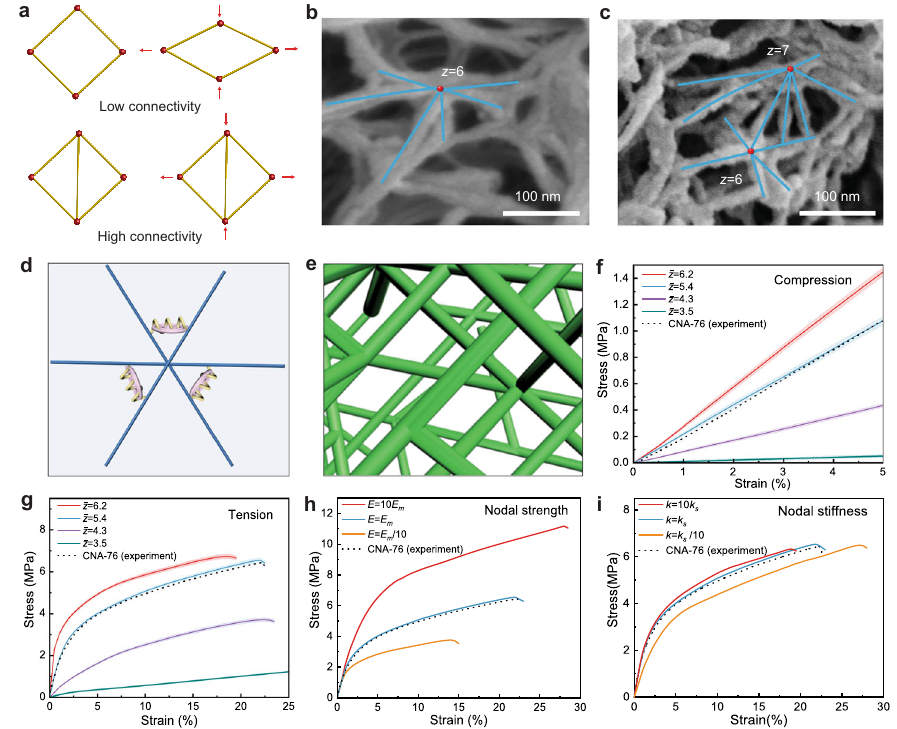
Fig. 3 Theoretical stimulation. a Examples of pin-jointed truss networks illustrating the distinct rigidity levels originating from different nodal connectivity. b , c SEM images of CNAs showing random 3D network with high-connectivity nodes. d A schematic model with linear and rotational springs connecting each pair of crosslinked fi brils. If a welded node contains three crosslinked fi brils, 3 pairs of linear and rotational springs will be introduced to represent the interconnection among them. e A 3D network representing CNA with an average nodal connectivity of (cid:1) z ¼ 5 : 4. f , g Effects of average nodal connectivity on the compressive ( f ) and tensile ( g ) responses of the simulated random 3D networks. Results from the simulation of (cid:1) z ¼ 5 : 4 match the experimental observations from CNA-76. h, i Effects of nodal strength represented by the binding energy, E ( h ), and nodal stiffness represented by the spring constant, k s ( i ), of the crosslinkers, on the tensile responses of simulated 3D networks with an average nodal connectivity of (cid:1) z ¼ 5 :